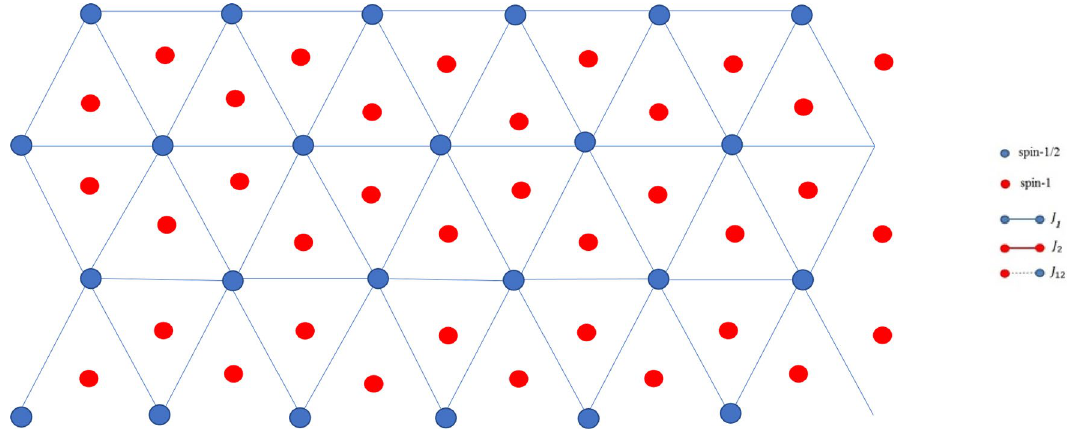
Fig. 1 Schematic representation of the centered honeycomb-hexagonal structure. The blue circles are atoms of spin 1/2 (sublattice-A). The red circles are atoms of spin 1 (sublattice-B). Different exchange interactions are shown in the mid-right of the